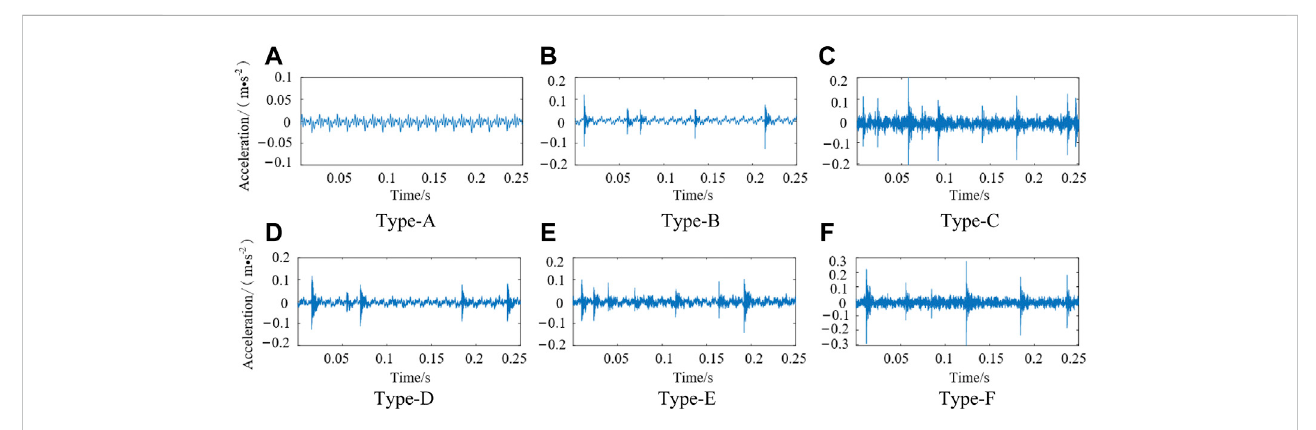
FIGURE 7 Vibration signals under six working